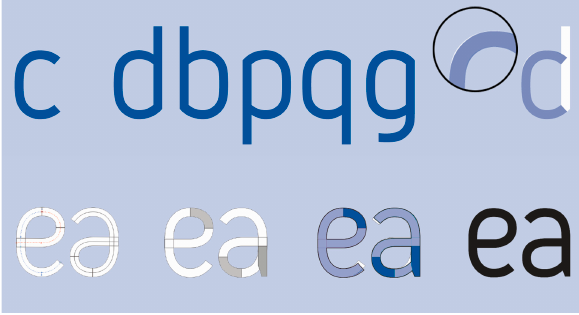
Figure 12. Specific attributes of the typeface ‘Grid Sans.’